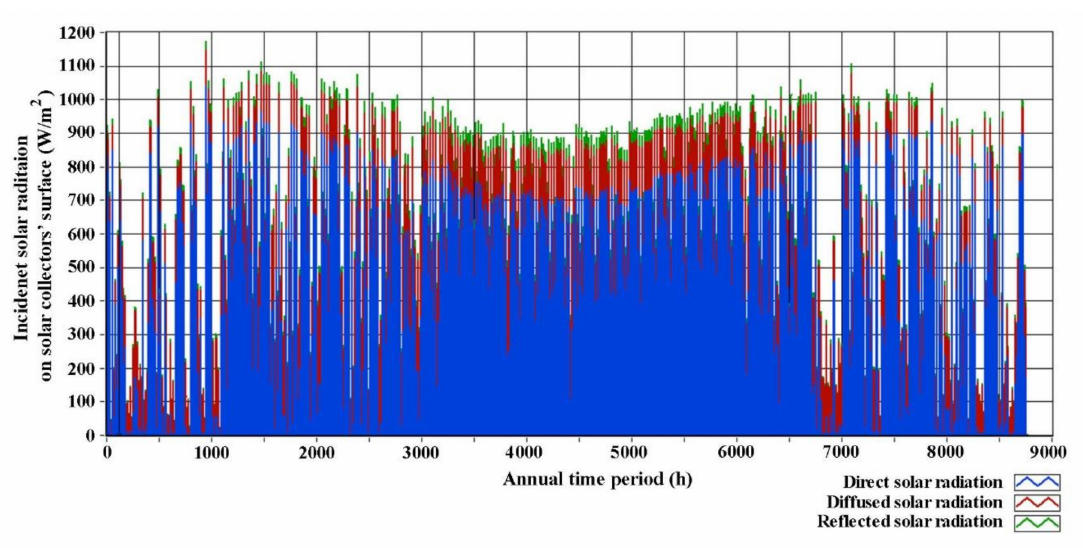
Figure 12. The annual fluctuation of the incident solar radiation on the solar collectors’ surface for the selected installation angle of 45 ◦